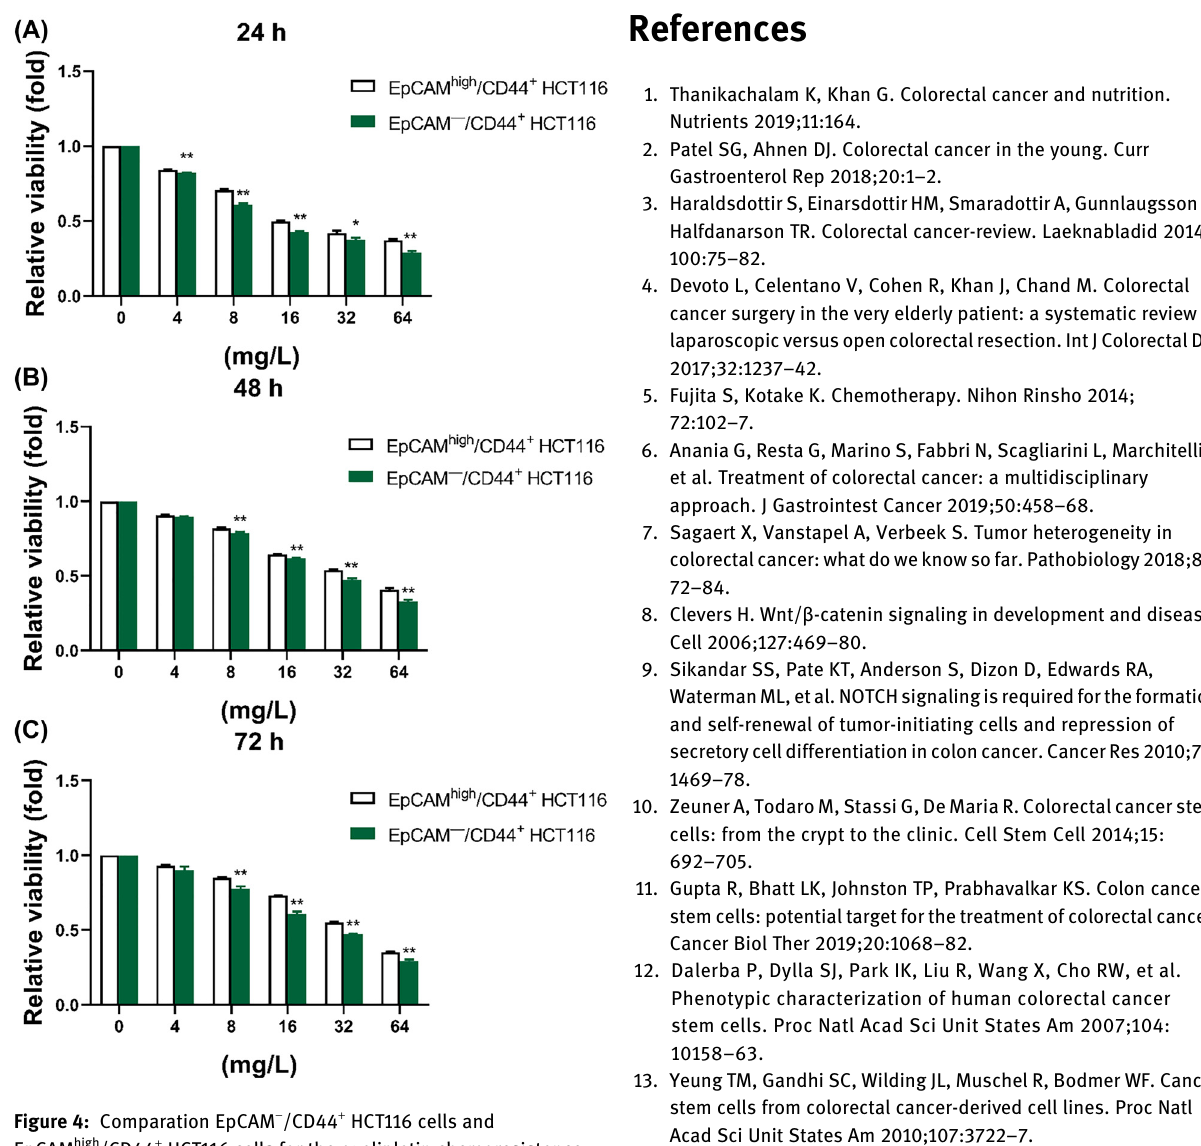
Figure 4: Comparation EpCAM − /CD44 + HCT116 cells and EpCAM high /CD44 + HCT116 cells for the oxaliplatin chemoresistance after 24 (A), 48 (B) and 72 (C) hours. *p<0.05, **p<0.01 vs. control